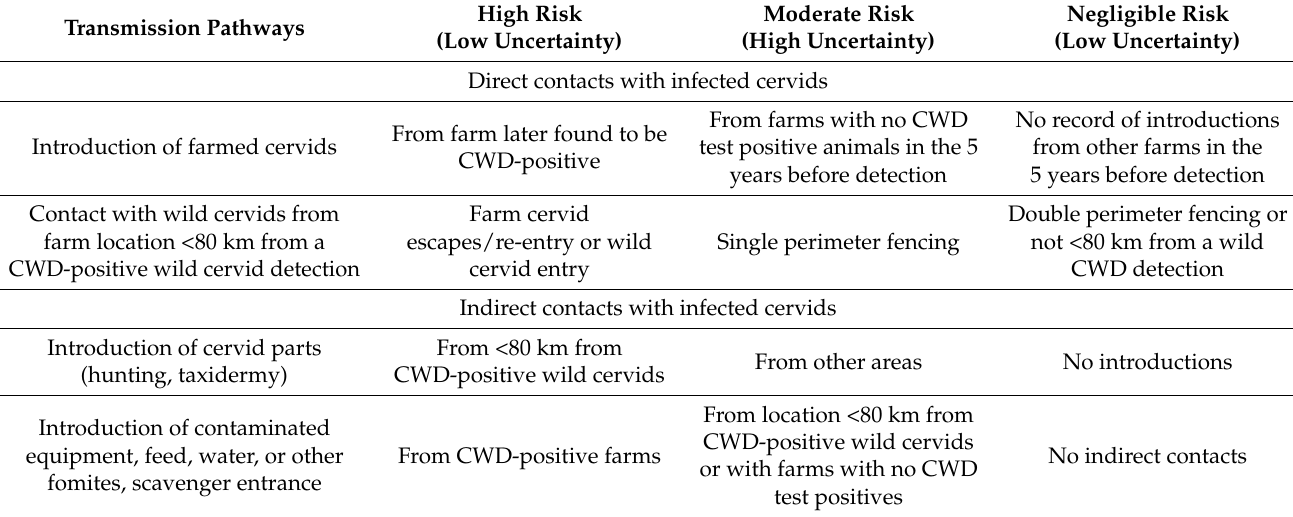
Table 2. Risk of CWD transmission exposures to cervid